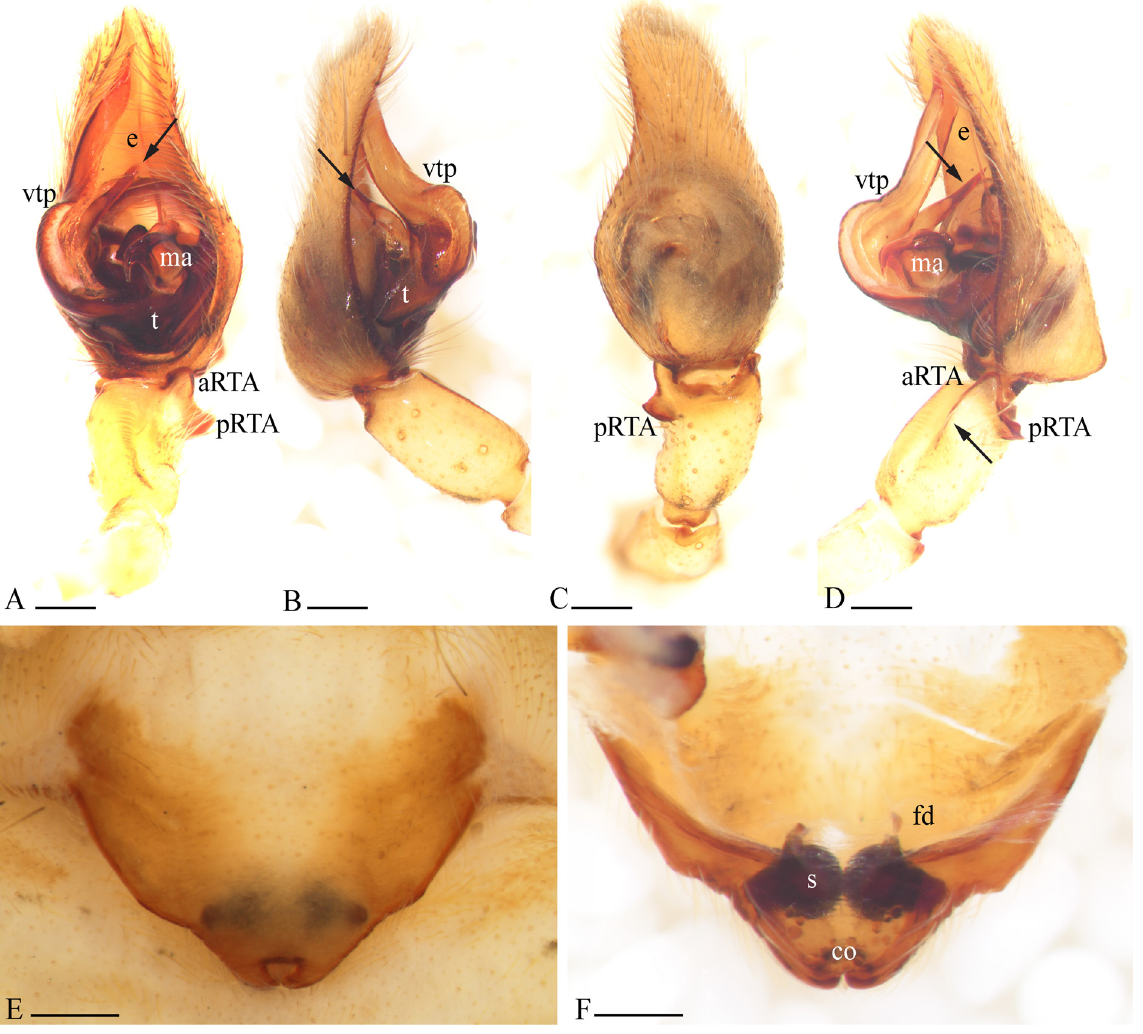
Fig. 20. Anyphaena bifurcata sp. nov. A–D . Paratype, ♂ (CNAN-T01549). E–F . Paratype, ♀ (CNAN-T01550). A . Pedipalp, ventral view. B . Pedipalp, prolateral view. C . Pedipalp, dorsal view. D . Pedipalp, retrolateral view. E . Epigynum, ventral view. F . Epigynum, dorsal view. Scale bars: 0.2